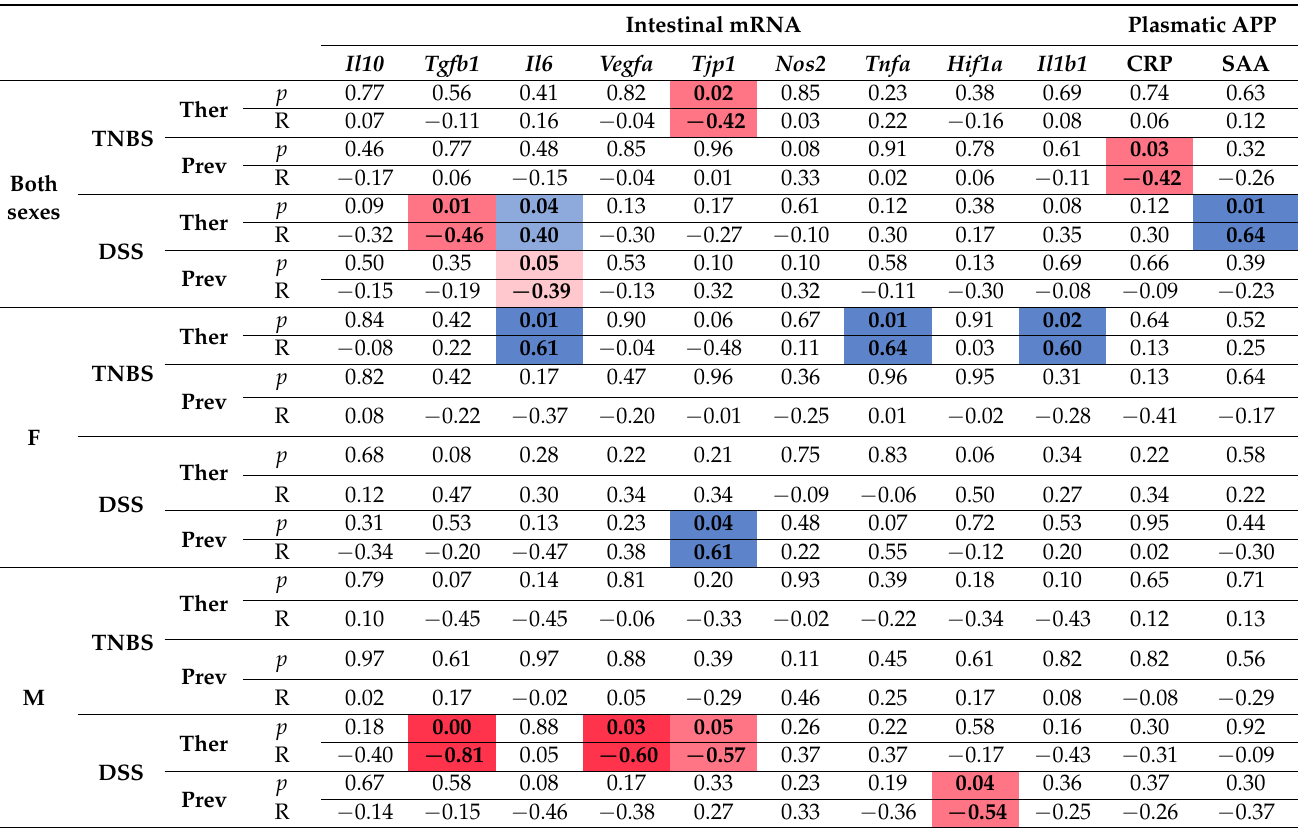
Table 1. BLI raw data correlation to mRNA and protein levels from inflammatory and oxidative markers of the animals stratified by colitis model, experimental trial, and